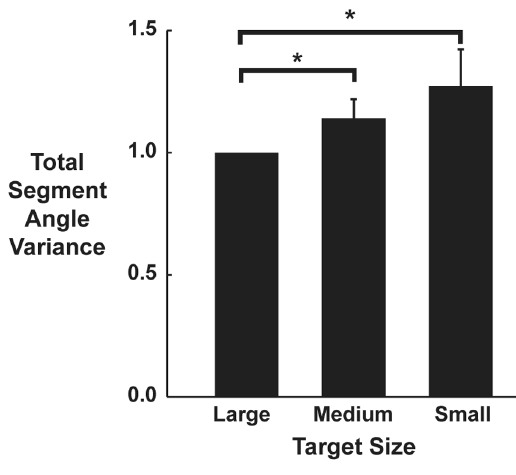
Figure 1. Total variance increases with smaller target sizes. Total segment angle variance normalized to large target condition. Bars are the averaged total variances for all subjects with 6 1 standard deviation. *denotes significant difference (p , 0.05).